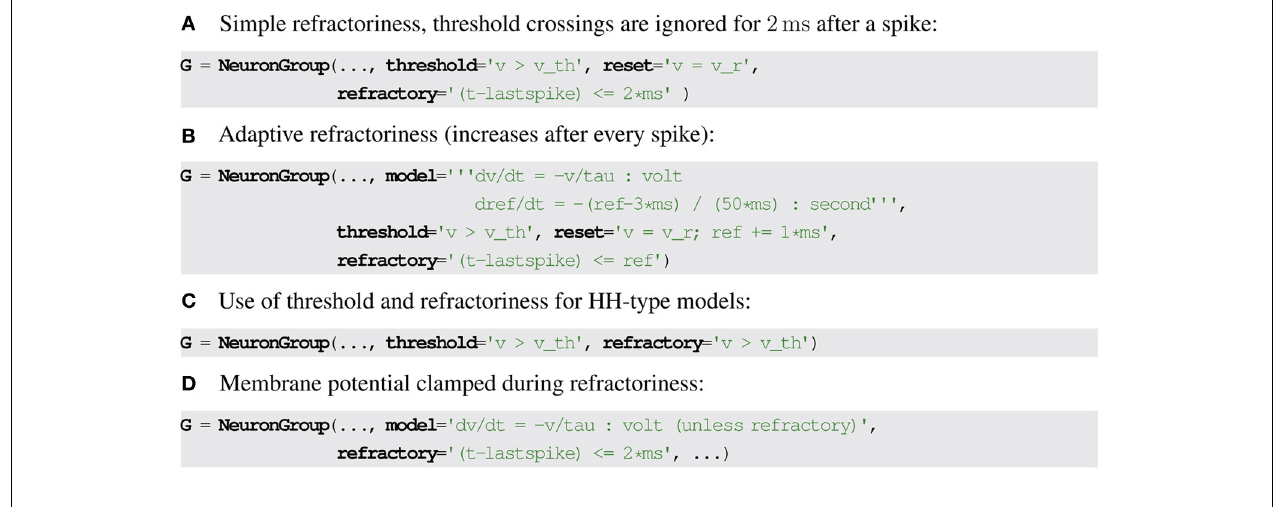
crossing. (D) Modifying differential equations based on refractoriness state, the keyword unless refractory clamps a variable x during the refractory period, i.e., d x d t =